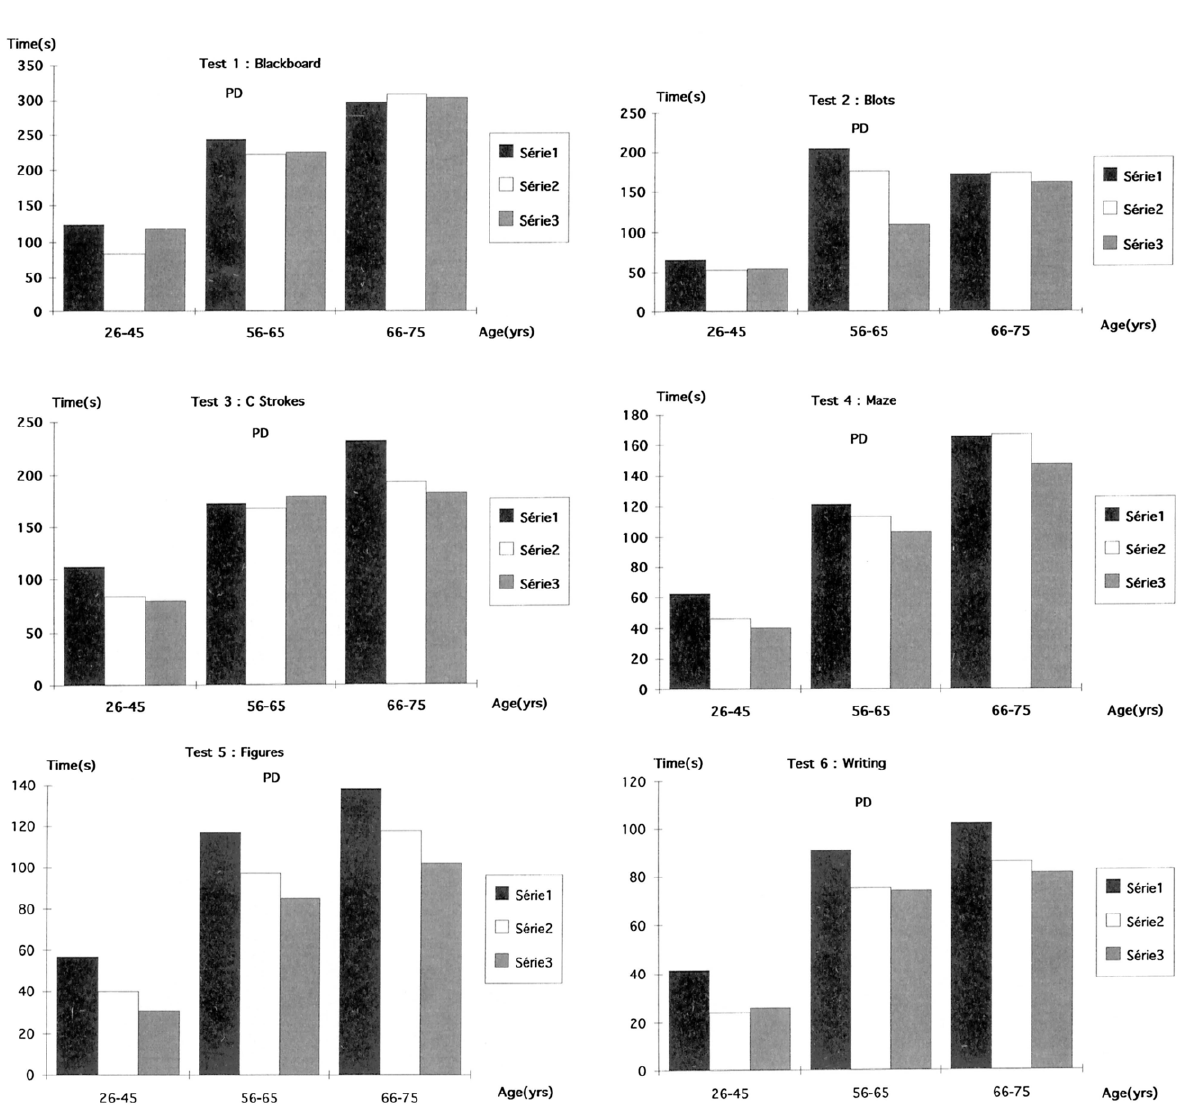
FIG. 2. Performance of three PO age group. Mean response times in six tests for three